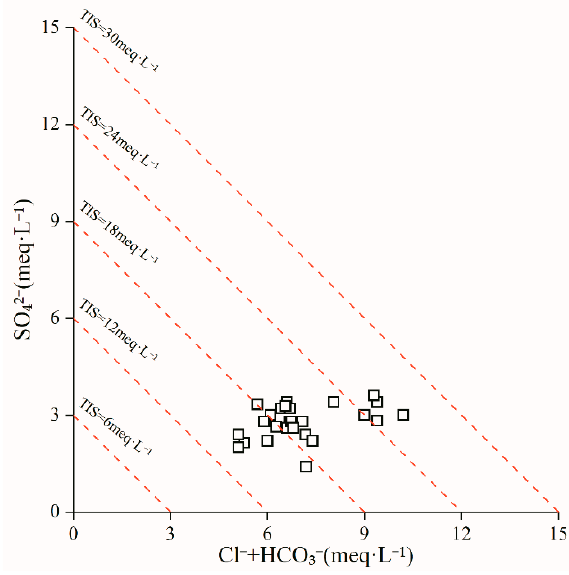
Figure 3. TIS salinity diagram of Sr-rich groundwater.